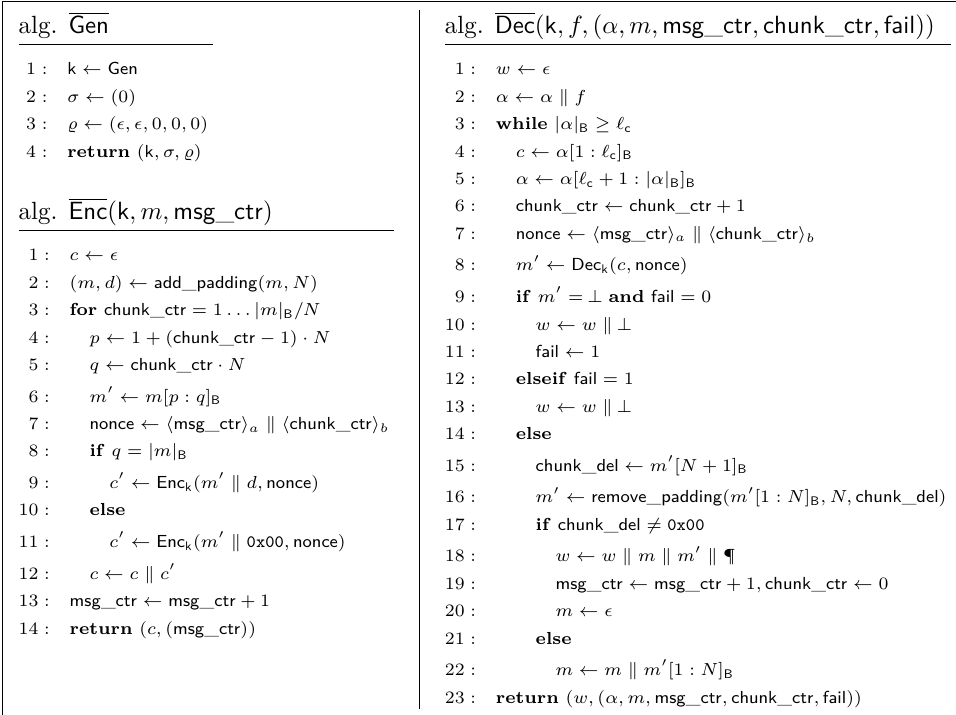
Figure 9: The modified InterMAC scheme IM ; functions add _ padding and remove _ padding are defined in Figure 10.